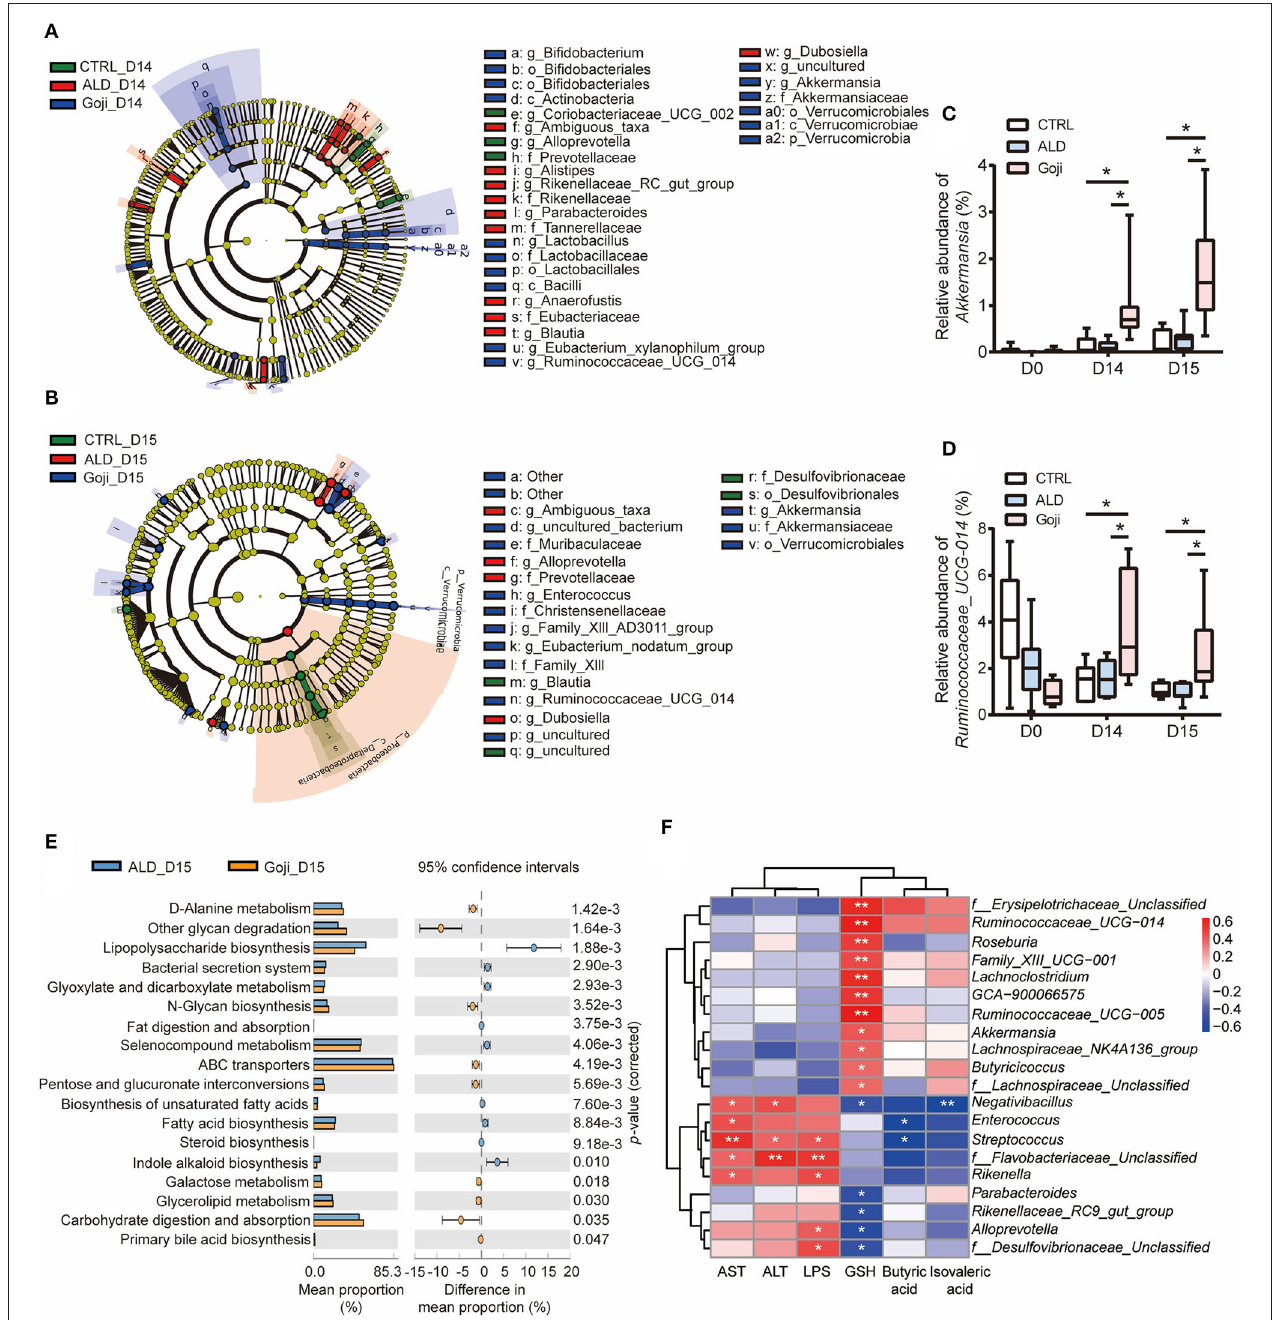
FIGURE 3 | Significantly different taxa between experimental groups and prediction of metabolic function. (A) LEfSe taxonomic cladograms are processed to identify specific taxa at different levels after Goji pretreatment for 14 days (D14). (B) specific taxa between CTRL, ALD, and Goji groups after alcohol shock at D15. Significantly discriminant taxon nodes are colored, and branch areas are shaded according to the effect size of taxa. Green taxa enriched in CTRL group; Red taxa enriched in ALD group; Blue taxa enriched in Goji group. Only the taxon whose LDA score > 3 is displayed. The species with no significant difference were colored yellow. Prefixes represent abbreviations for a taxonomic rank of each taxon, with phylum (p), class (c), order (o), family (f), and genus (g). (C) relative abundance of Akkermansia . (D) relative abundance of Ruminococcaceae_UCG_014 . Data are shown as mean ± SEM ( n = 7–8), and statistical significance assessed by one-way ANOVA corrected for multiple comparison by Tukey’s test. (E) significant differences in metabolism pathway between ALD and Goji at Day 15. P -values were calculated using Welch’s test. (F) the Spearman’s correlation between the liver-related index and the relative abundance of significantly different genera. The scale represents the correlation coefficients. * p -value < 0.05, ** p -value < 0.01.